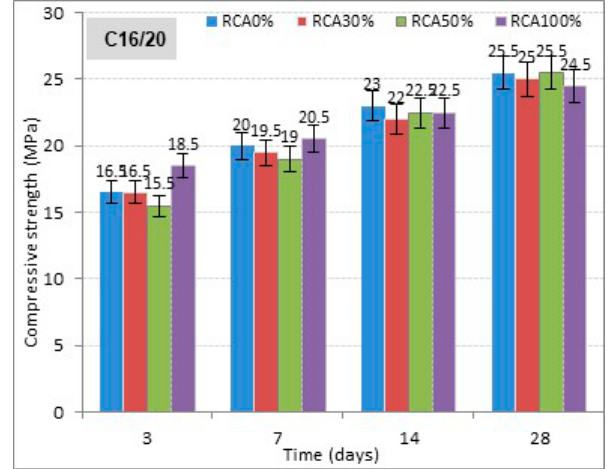
Figure 3. Compressive strength development for C16/20 concretes with various proportions of RCA. Buildings 2020 , 10 , x FOR PEER REVIEW